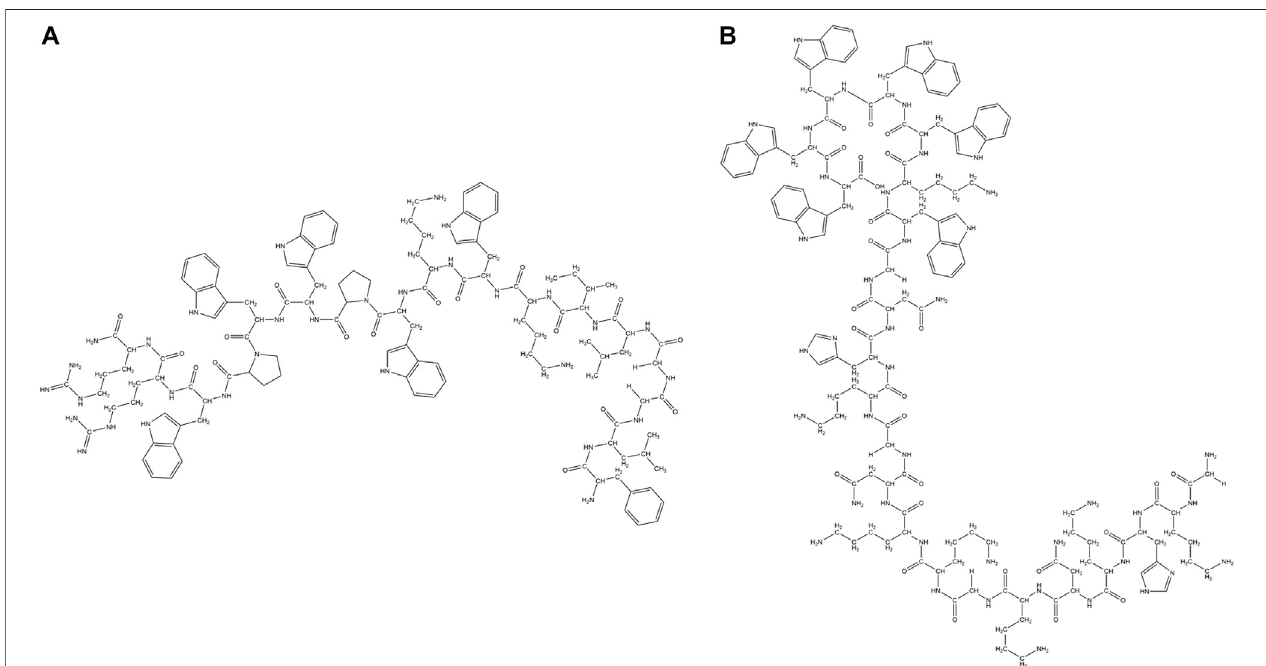
FIGURE9| ExamplesofsyntheticAMPsrichinspeci fi caminoacidresidues(Trp,Pro,HisandGly). (A) Trp-Prorichpeptide:RN7-IN10(Jindaletal.,2017). (B) Trp- Gly rich peptide: GKH17WWWWW (Pasupuleti et al., 2009).